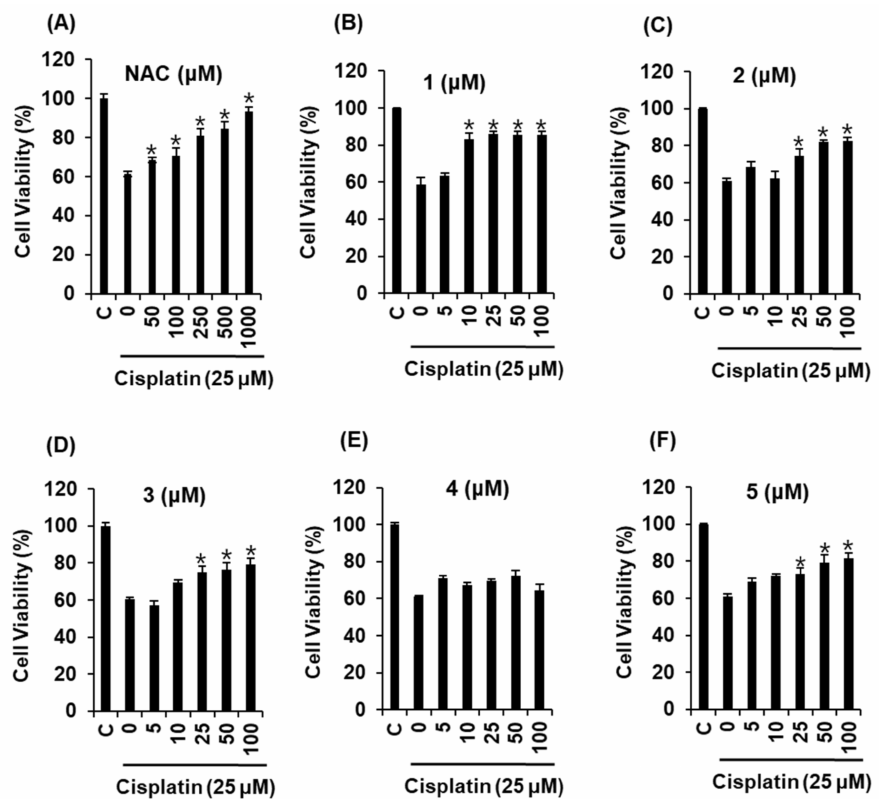
Figure 2. Comparison of protective effects of compounds 1 – 5 against cisplatin-induced cytotoxicity